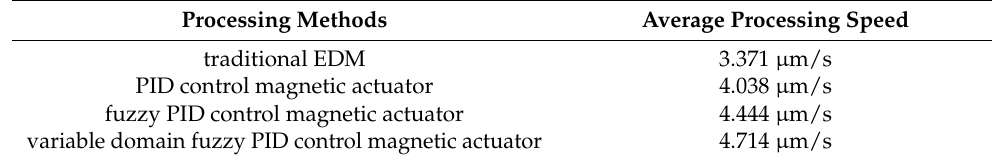
Table 7. Experimental result analysis table.